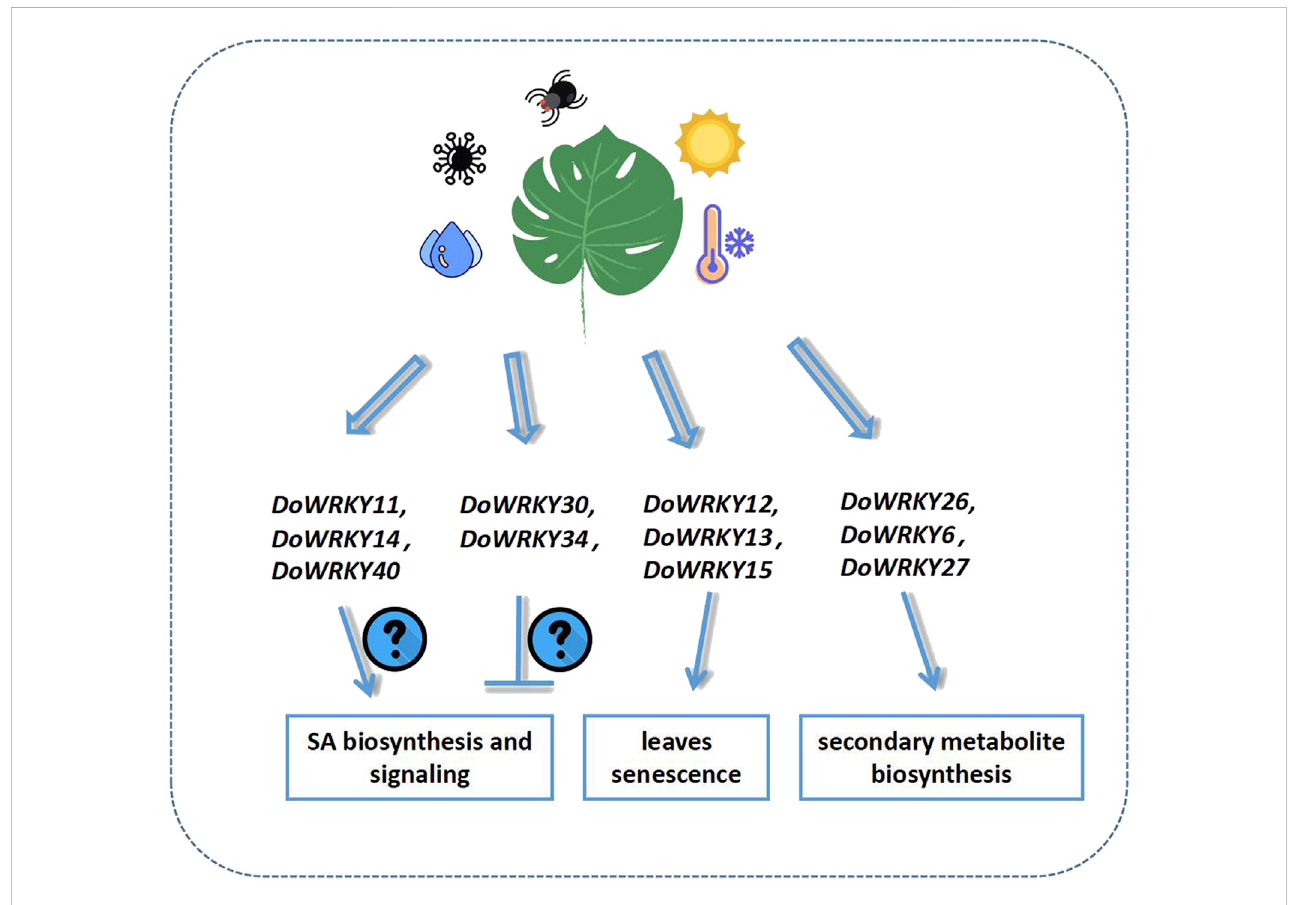
The putative roles of some DoWRKYs in D. of fi cinale